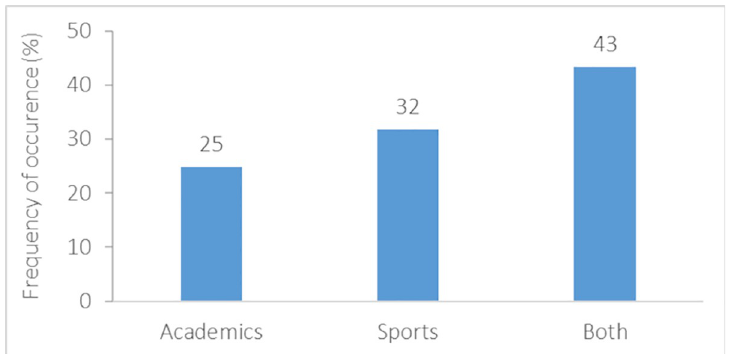
Fig 8. Reasons for relocation of migrating